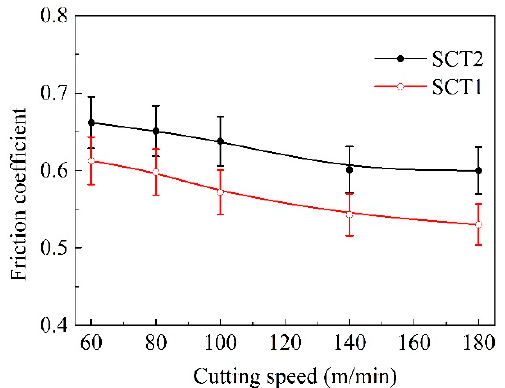
Figure 11. Friction coefficient at the tool-chip interface of SCT1 and SCT2 at different cutting speeds ( a p = 0.2 mm, f = 0.1 mm/r, cutting time 5 min) .